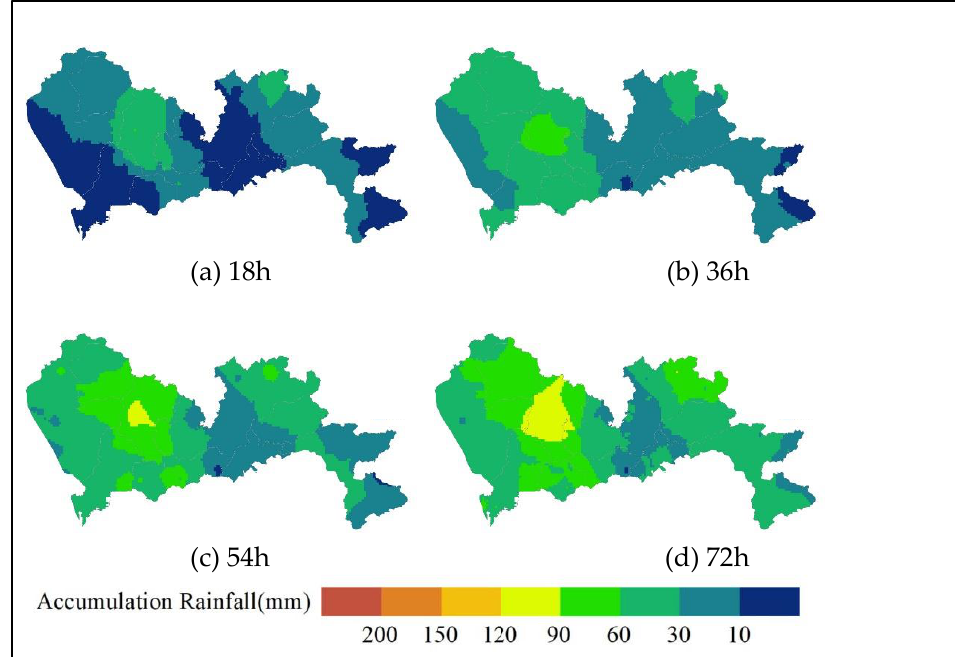
Figure 7. Rainfall accumulation of rainstorm of type I occurred on 22 May 2009.